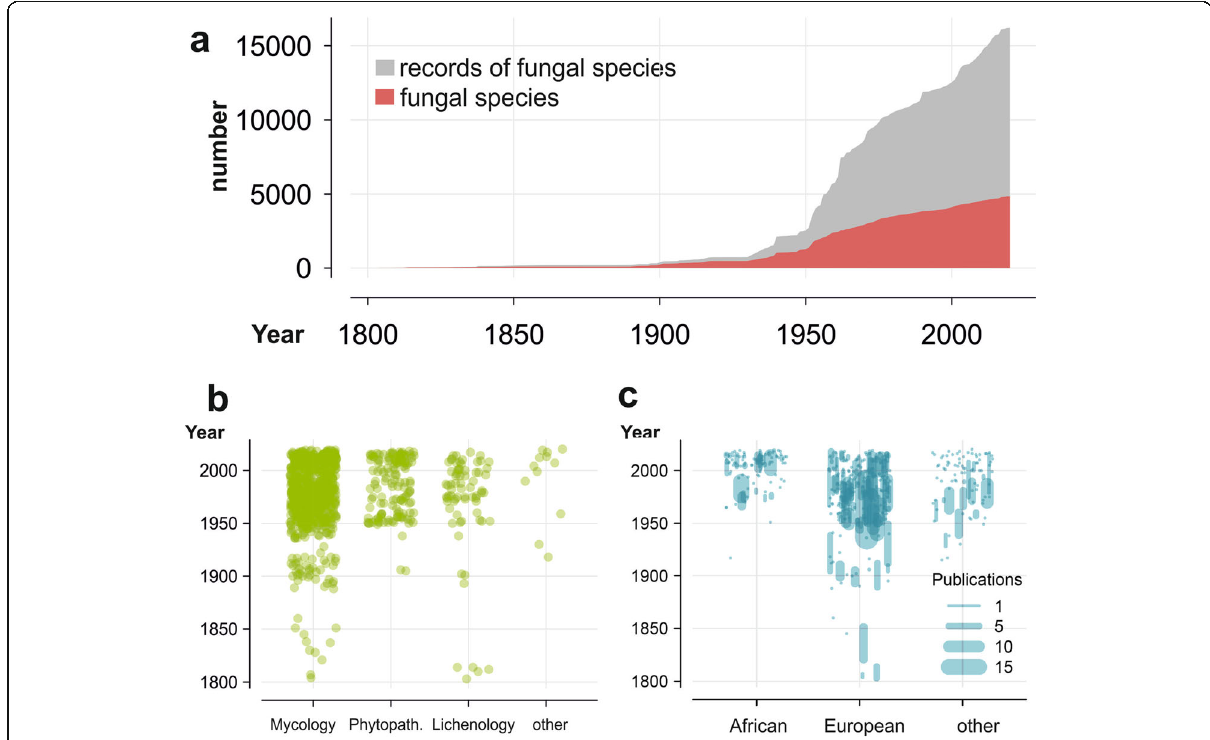
Fig. 3 Increase of knowledge on the diversity of fungi and fungus-like organisms in West Africa over time. a Knowledge increasing over years. The upper limit of the grey area shows the increasing number of records and the red area the cumulative number of species and infraspecific taxa reported for West Africa. b Research fields yielding records of fungal species over time. Publications are attributed to mycological, phytopathological/agricultural, or lichenological research fields. Each green dot corresponds to one publication. c Origin of first authors of publications including records of fungal species over time. One dot or line reflects activities of one first author. The length of the lines indicates the range of years in which a given author published. The width of the lines is proportional to the number of publications from that